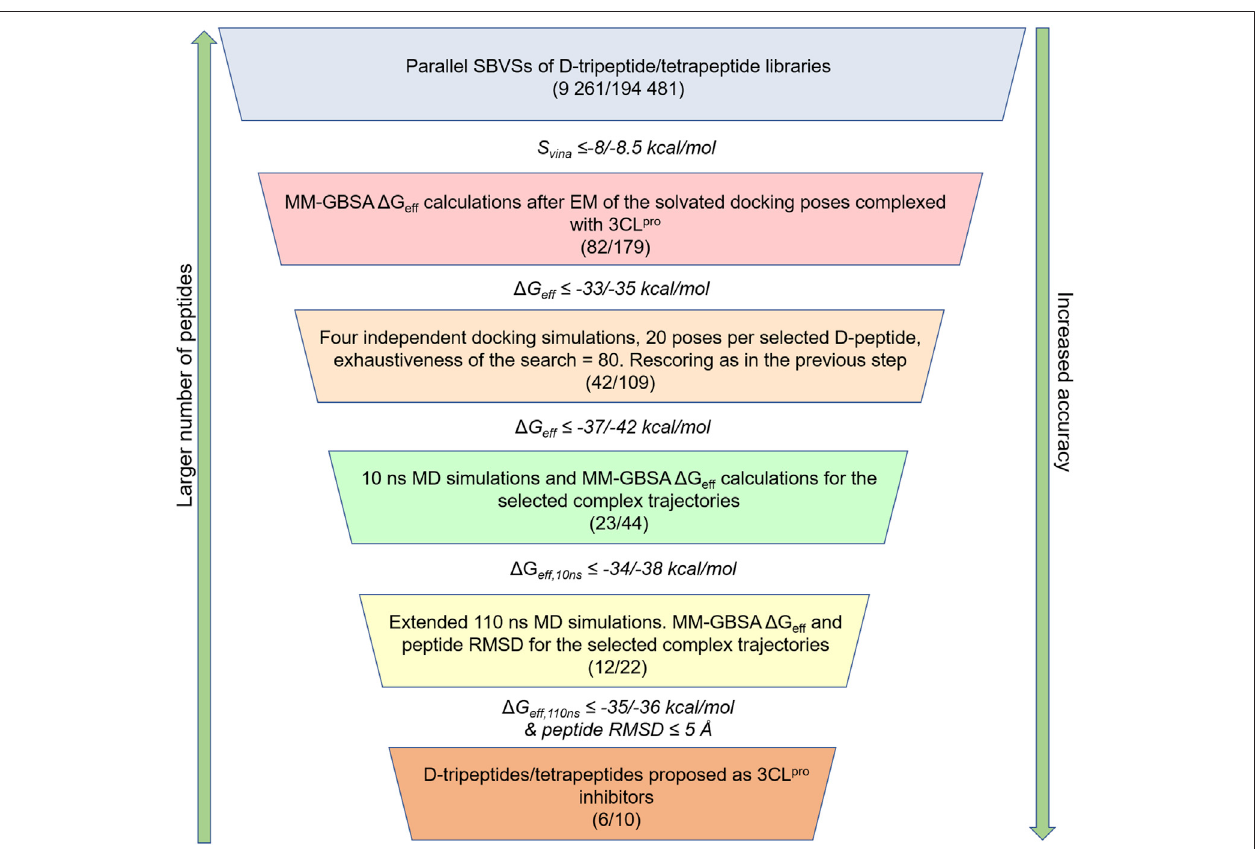
FIGURE 1 | Work fl ow employed for the identi fi cation of potential D-peptides targeting the 3CL pro active site. The number of D-tripeptides and D-tetrapeptides analyzedinparallelthroughoutthework fl owisshown inparentheses,i.e.,(numberofD-tripeptides/number ofD-tetrapeptides).Thecut-offs usedtoselectthepeptides ateverystepareindicatedasfollows:cut-offforD-tripeptides/cut-offforD-tetrapeptides.Thesevaluesweresetonthebasisoftheresults,sothatamanageablenumber of D-peptides would be selected for the next step.